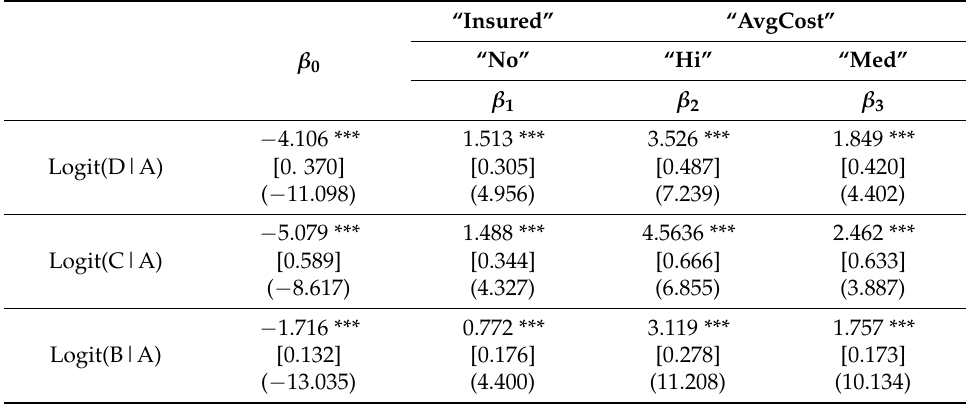
Table 13. Estimation of treatment outcome against status of insurance and daily